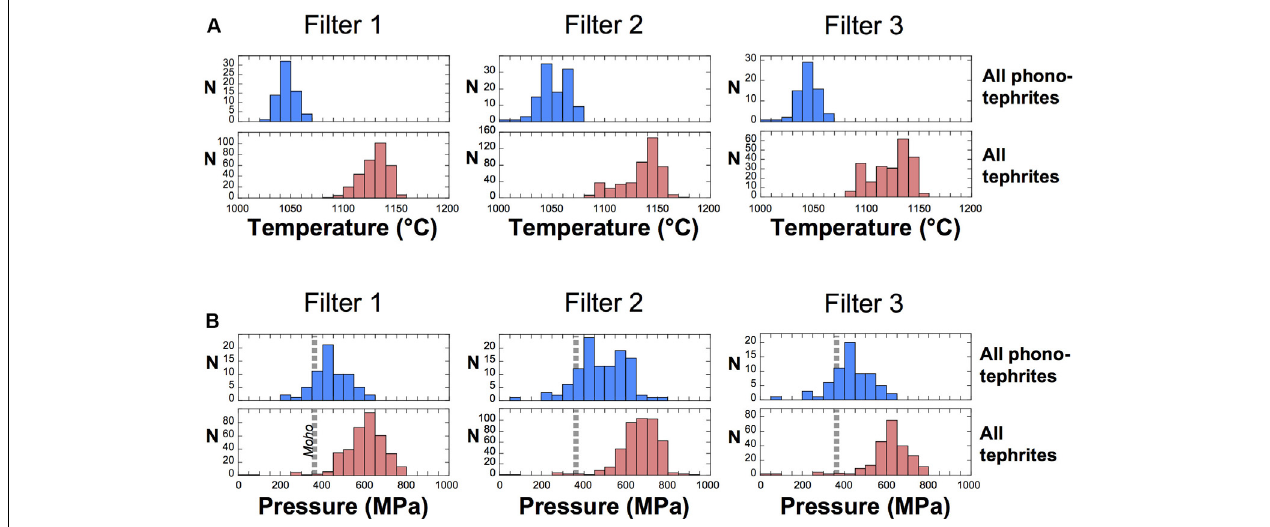
FIGURE 5 | Summarized results of clinopyroxene-melt thermobarometry using the Putirka et al. (2003) calibration. Shown are the data for all clinopyroxenes in phonotephrites (blue) and in tephrites (red); N is the number of values. Data were filtered as described in the text and show little dependency of the filter used. (A) Temperature histograms with 10 ◦ C bins. (B) Pressure histograms with 50 MPa bins; dashed lines mark the approximate pressure at Moho depth after the crustal model of Pim et al. (2008).